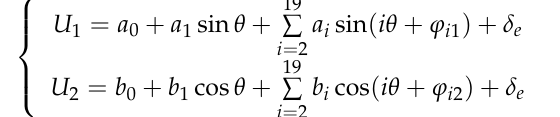
Figure 1. Photoelectric encoder explosion structure diagram.